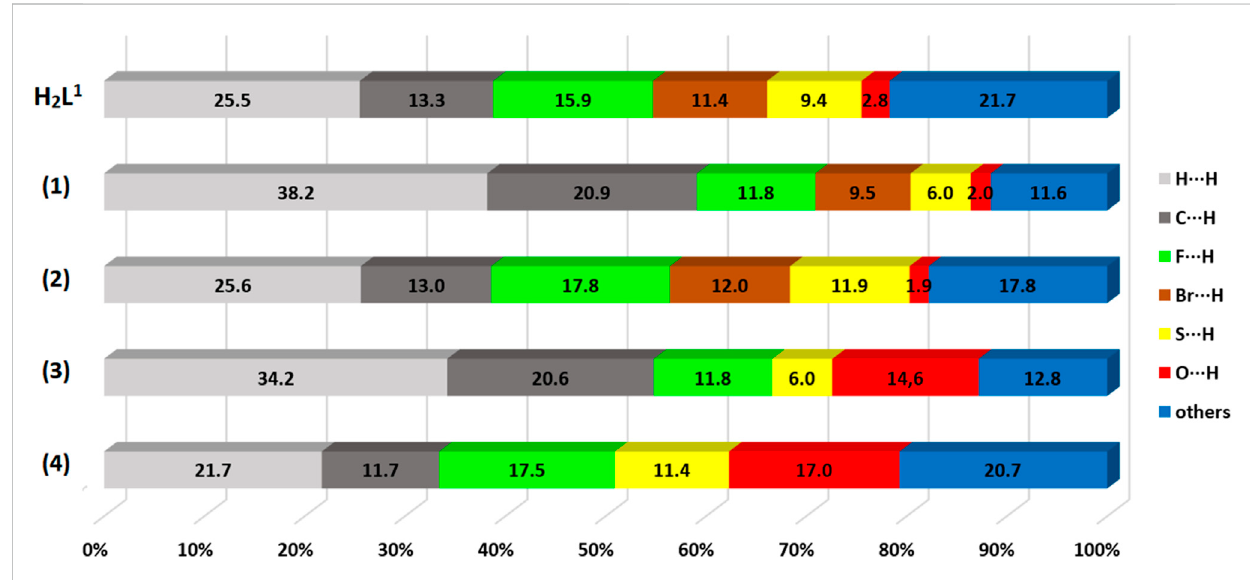
Percentage contribution of close contacts for H 2 L 1 and the complexes (1 –